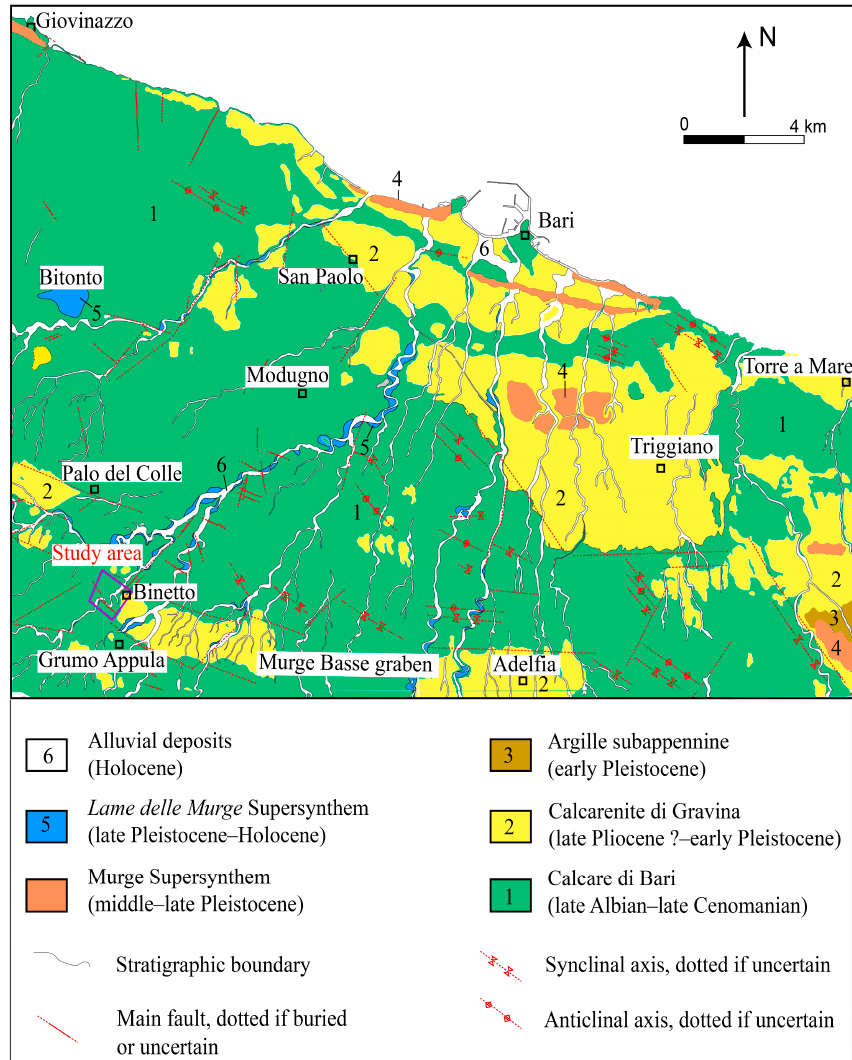
Figure 2. Simplified geological map of the Sheet 438 “Bari” (modified after Reference [33]). See Figure 1 for map location.